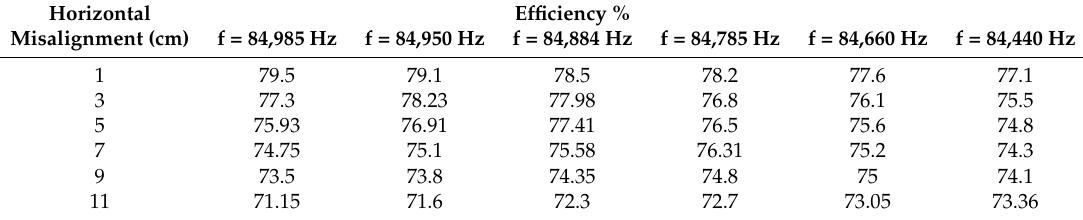
Table 3. Efficiency corresponding to the horizontal misalignment under various operating